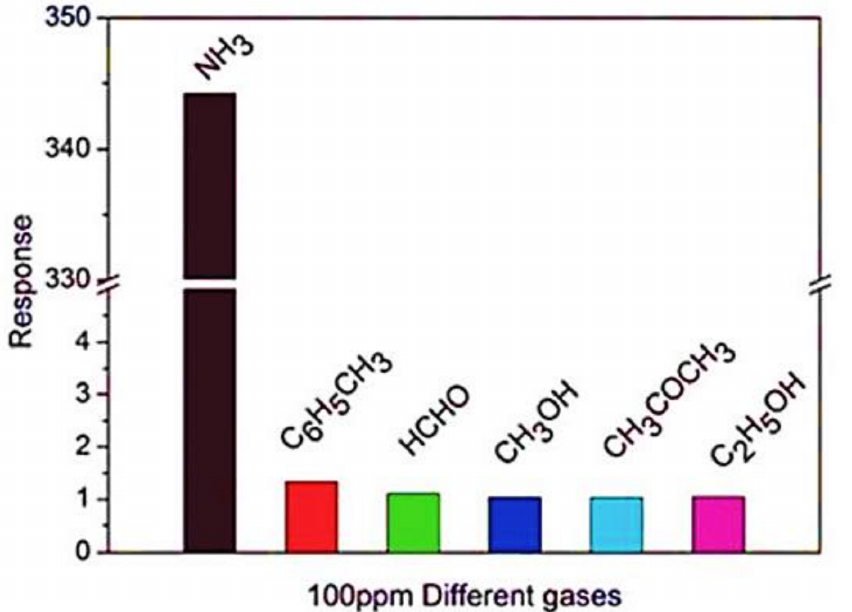
Figure 16. Sensitivity response of reduced graphene-oxide–PANI hybridized thin films towards various gases at 100 ppm. Reproduced with permission from